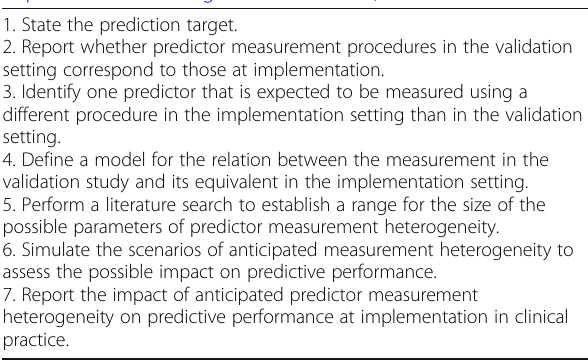
Table 2 Quantitative prediction error analysis to quantify the impact of anticipated predictor measurement heterogeneity at implementation of a prognostic model in clinical practice (details in section “ Quantifying the impact of anticipated predictor measurement heterogeneity between validation and implementation setting ” of the main